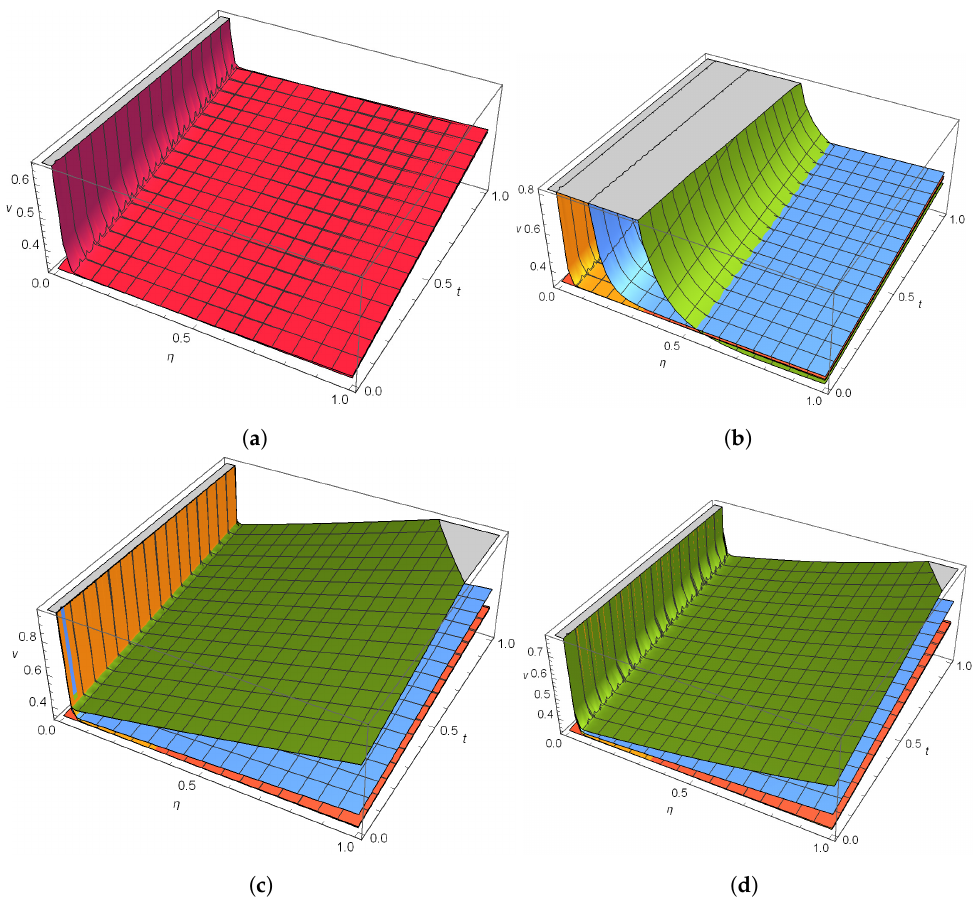
Figure 2. 3-D Plot of α -HATM solution for YAC operator with exact solution for case 2 when γ = 0.99. ( a ) α -HATM solution with exact solution. ( b ) α -HATM solution with the exact solution for distinct values of k, Yellow (k = − 0.19), Blue (k = − 1), Green (k = − 2), Red (Exact Solution). ( c ) α -HATM solution with exact solution for distinct values of r, Yellow (r = 1), Blue (r = 2), Green (r = 3), Red (Exact Solution). ( d ) α -HATM solution with exact solution for distinct values of χ , Yellow ( χ = 1), Blue ( χ = 5), Green ( χ = 10), Red (Exact Solution).